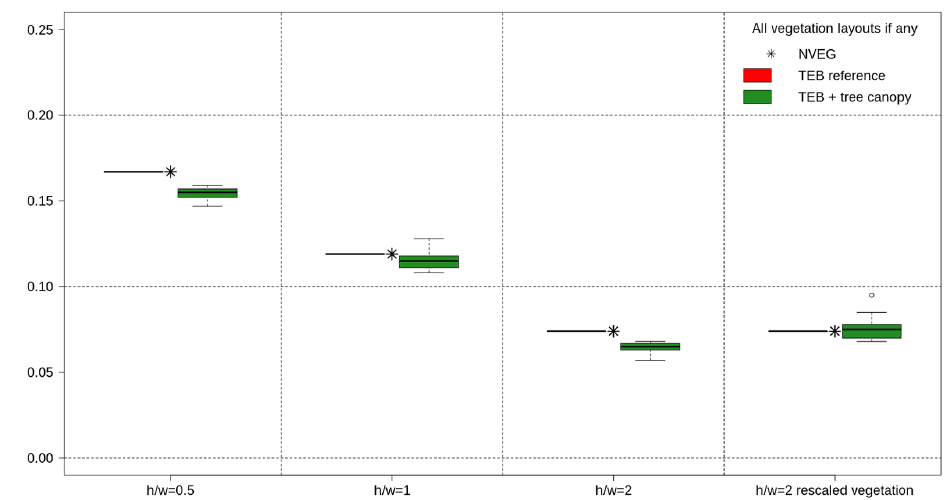
Figure 9. Comparison of the canyon albedo at solar noon between the reference TEB simulations without distinction between low and high vegetation, and the new version including a tree canopy by aspect ratios for all vegetation layouts combined within north–south-oriented canyons during a summer day. See Sect. 5.2.1 and Fig. 2 for further explanations about the h/w = 2 rescaled vegetation